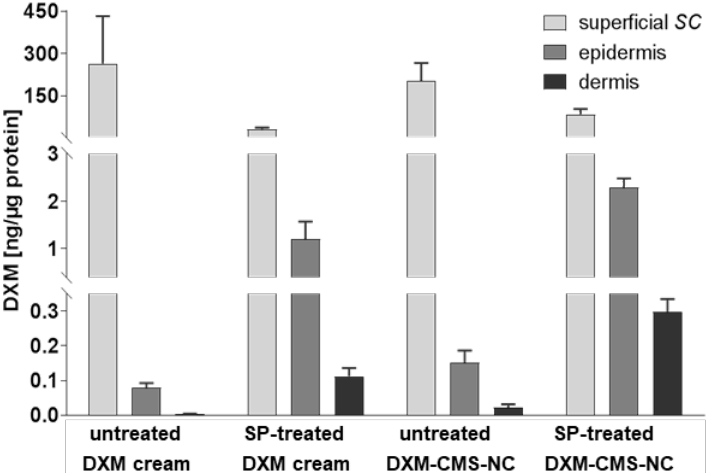
Figure 4. The SP treatment and CMS-NSC formulations increased the skin penetration of dexamethasone (DXM). The penetration of DXM after the topical application on the untreated and serine protease (SP)-treated ex vivo human skin was quantified in extracts of three different skin layers, superficial stratum corneum (s SC) , epidermis and dermis, by HPLC-MS/MS. DXM concentrations were normalized to the total protein content of each extract. Data are shown as mean (+SD), n = 5 donors for the untreated samples and n = 3 donors for the SP-treated samples.